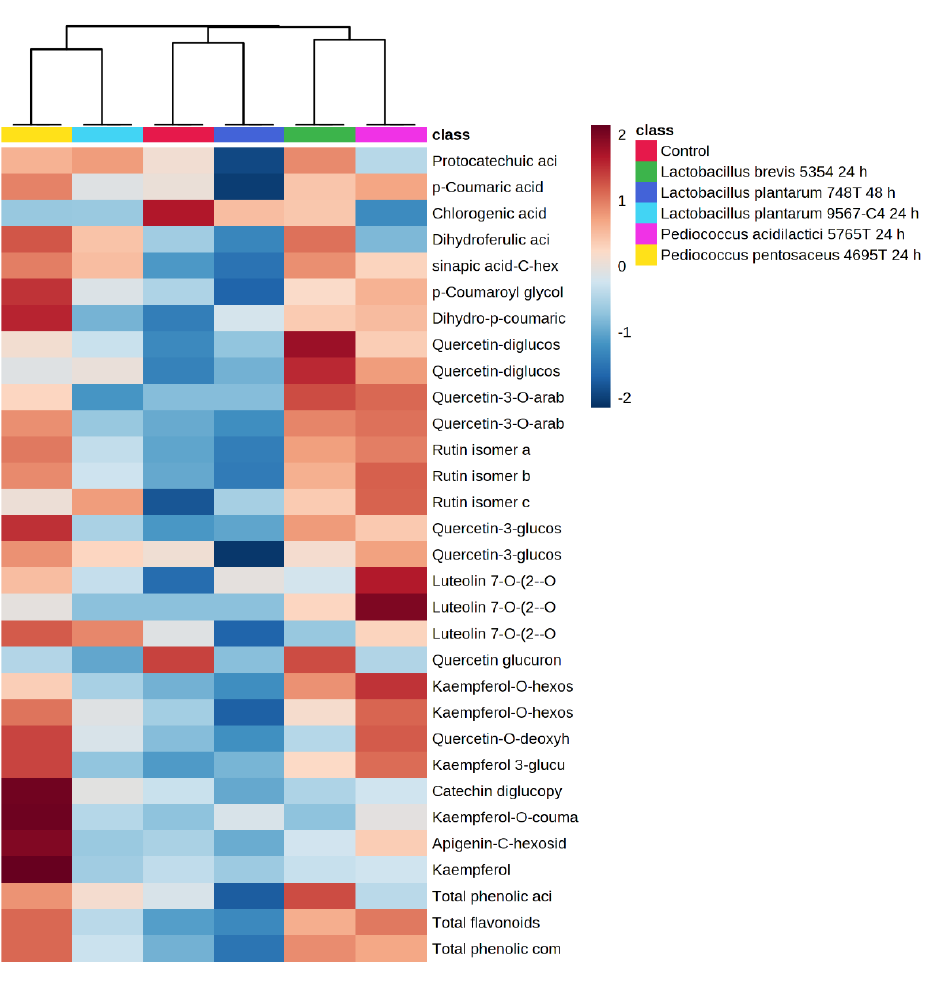
Figure 2. Clustering heatmap of the avocado leaves fermented by the selected strains and control. As can be seen from the figure, the avocado leaf fermented by L. plantarum 748T at 48 h was clustered with the control sample, which shows the minor differences among them in the polyphenol profile, and it had the lowest total phenolic content but with the highest content of chlorogenic acid. Close to them, L. brevis 5354 and P. acidilactici 5765T were also clustered according to their phenolic profile, being the group that showed higher contents of luteolin and quercetin derivatives. Finally, the group that was clustered furthest from the control was the one composed by P. pentosaceus 4695T and L. plantarum 9567. It seems to be a heterogeneous group in terms of amounts but with a similar profile and proportions be- tween the individual phenolic compounds. Among them, P. pentosaceus 4695T was the strain that led the avocado leaf to release the highest content of coumaric acid derivatives and kaempferol derivatives with the highest total phenolic content. This clustering analysis con- firms the strain-specific metabolism of LAB on the phenolic compounds present in avocado leaves, which is dependent on the capability of strains to tolerate and hydrolyse them. 4. Conclusions This study allowed us to identify the chemical biotransformations induced by LAB strains in avocado leaves using submerged fermentations. A total of 48 polar compounds were identified by HPLC-ESI-TOF-MS and, to our knowledge, 15 of them were identified for the first time. We found a strain-specific metabolism of the phenolic compounds of